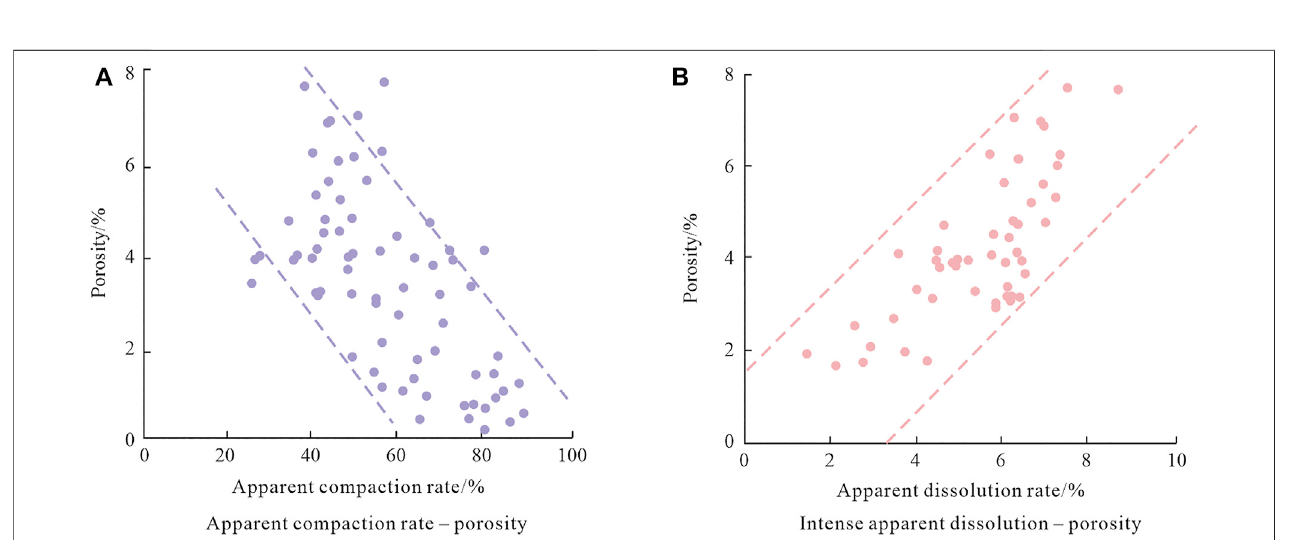
FIGURE 15 | Relationship between diagenesis parameters and reservoir porosity of the Xiaoheba Formation in the northern area; (A) Apparent compaction rate — porosity; (B) Intense apparent dissolution — porosity.